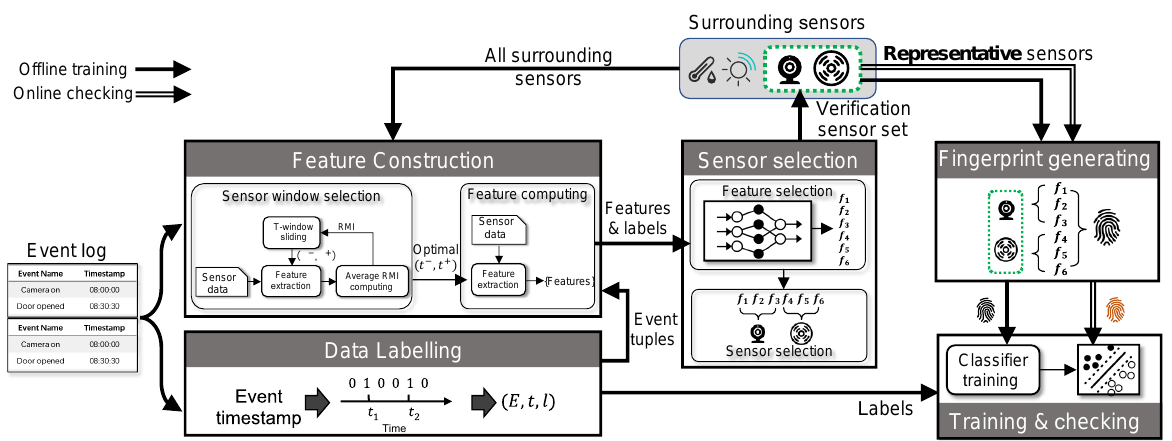
Fig. 3 Overall architecture of